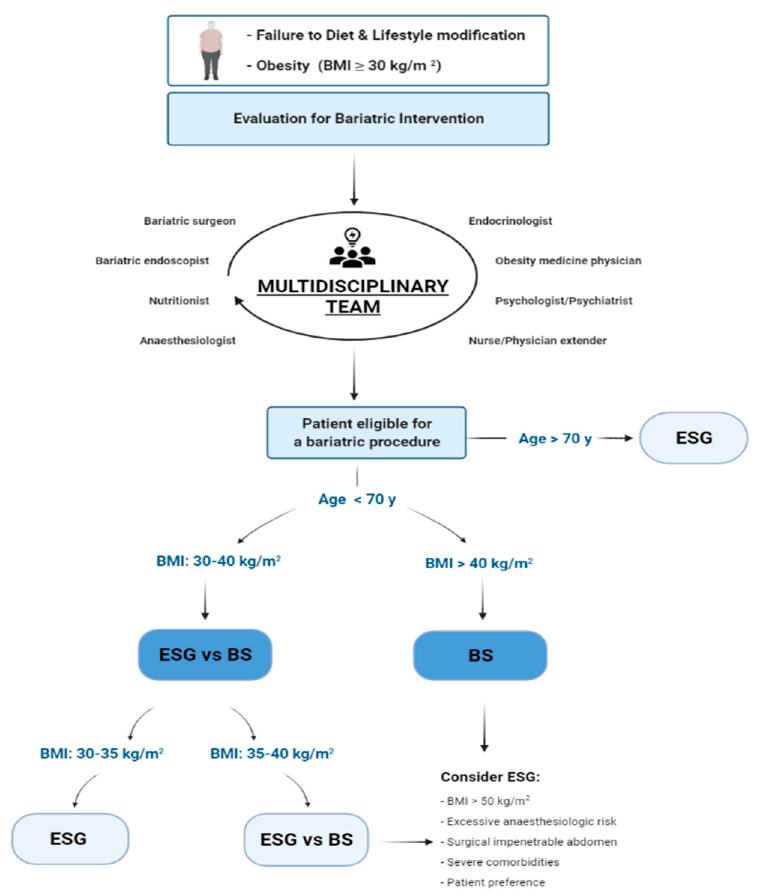
Figure 1. Flow chart for patient selection. BMI: Body Mass Index, BS: Bariatric Surgery, ESG: Endoscopic Sleeve gastroplasty.